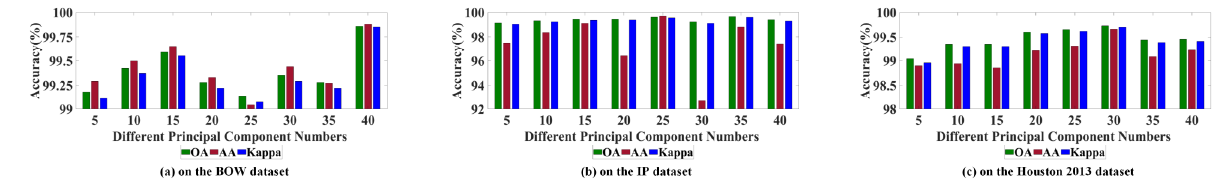
Figure 10. The classification results of different principal component numbers.